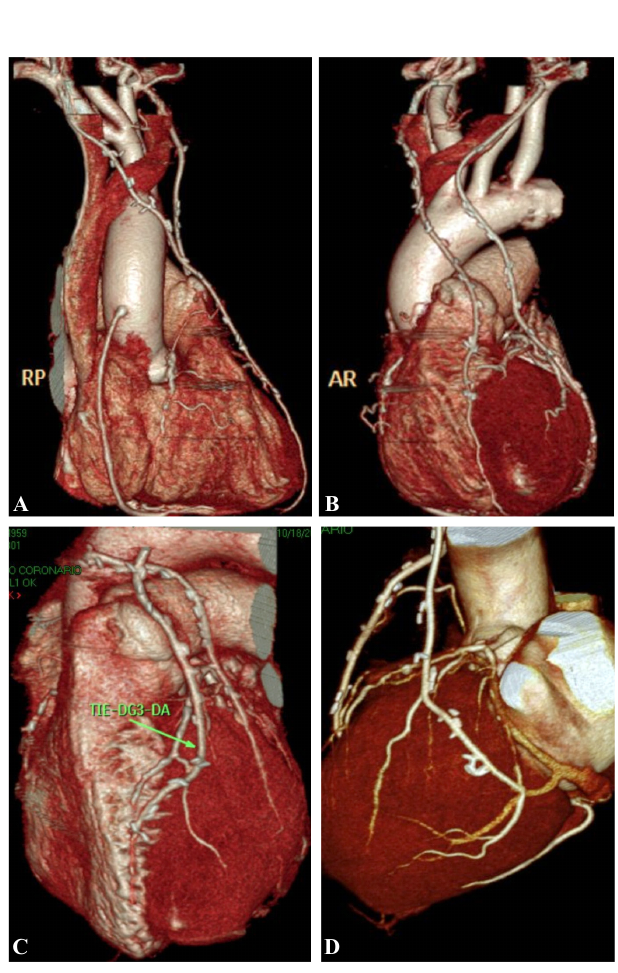
Fig. 3 - (A and B) Coronary CT angiography showing positioning of the right internal thoracic artery (RITA) in the cranial portion of the ascending aorta, anastomosed to the anterior interventricular branch (AIB). C) Left internal thoracic artery (LITA) anastomosed to AIB/ diagonal (sequential) and RITA (free) to the left marginal (LM). D)